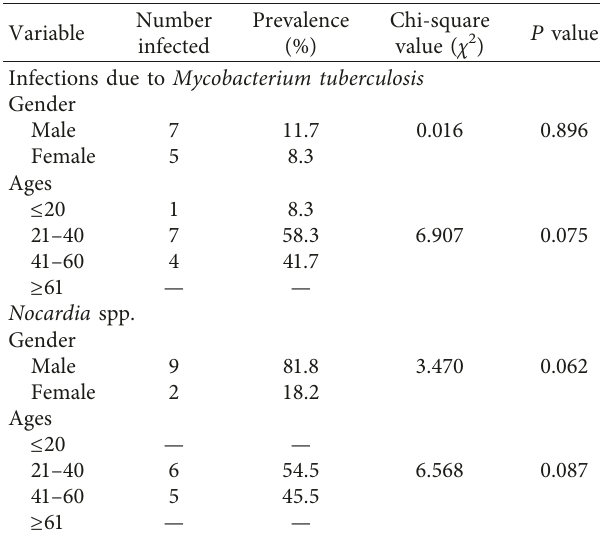
Figure 2: Amplification of Nocardia with IS1&2 primers: M: molecular weight marker, PC: positive control, NC: negative control, bp: base pairs (expected base pairs of Nocardia asteroides , 500bp). Table 1: Sociodemographic characteristics of study participants. Table 2: Prevalence of Nocardia spp. and Mycobacterium tuberculosis